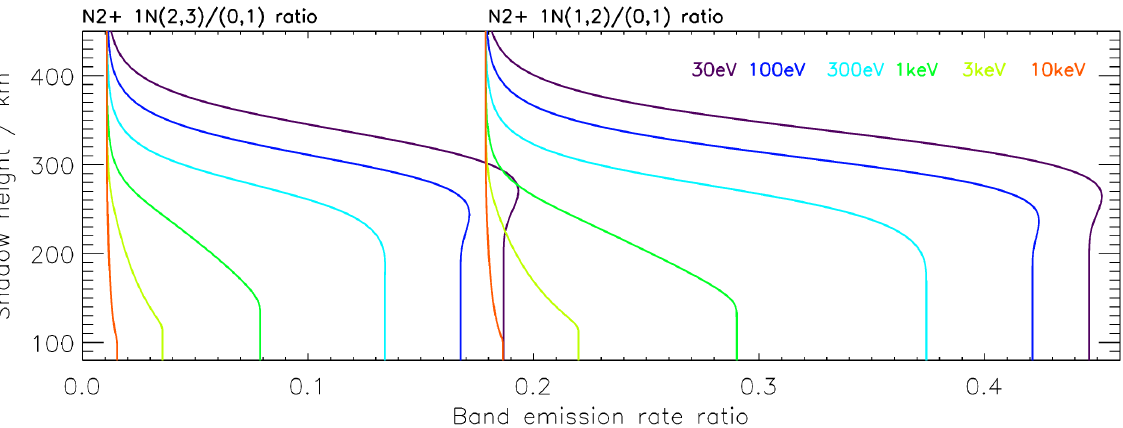
Fig. 8. Band brightness ratios as a function of shadow height for different primary electron energies for N + (1,2) / (0,1) (right).